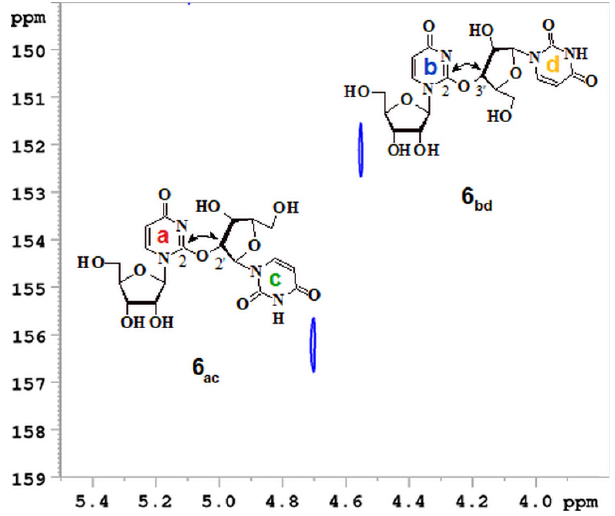
Figure 10. HMBC spectrum of 6 (regioisomer C2-O2 ′ with nucleobase rings ac and 2C-O3 ′ with nucleobase rings bd) and an extended region of the HMBC spectrum ( 1 H: 4.0–5.4 ppm and 13 C: 149–159 ppm) (D 2 O).